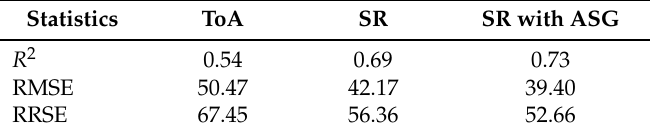
Table 2. Summary of the goodness ‐ of ‐ fit statistics for estimation of the AGB.